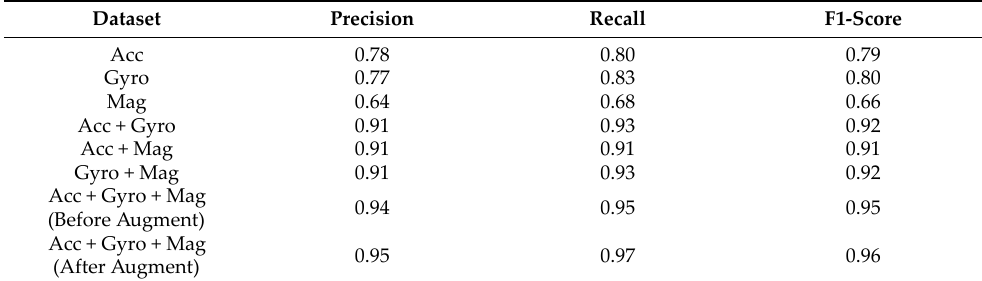
Table 6. Performance results for each dataset.